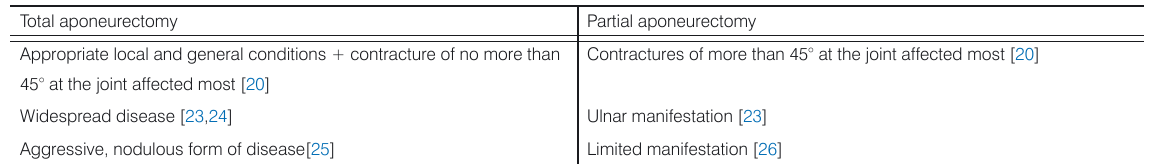
Table 2. Indications for total and partial